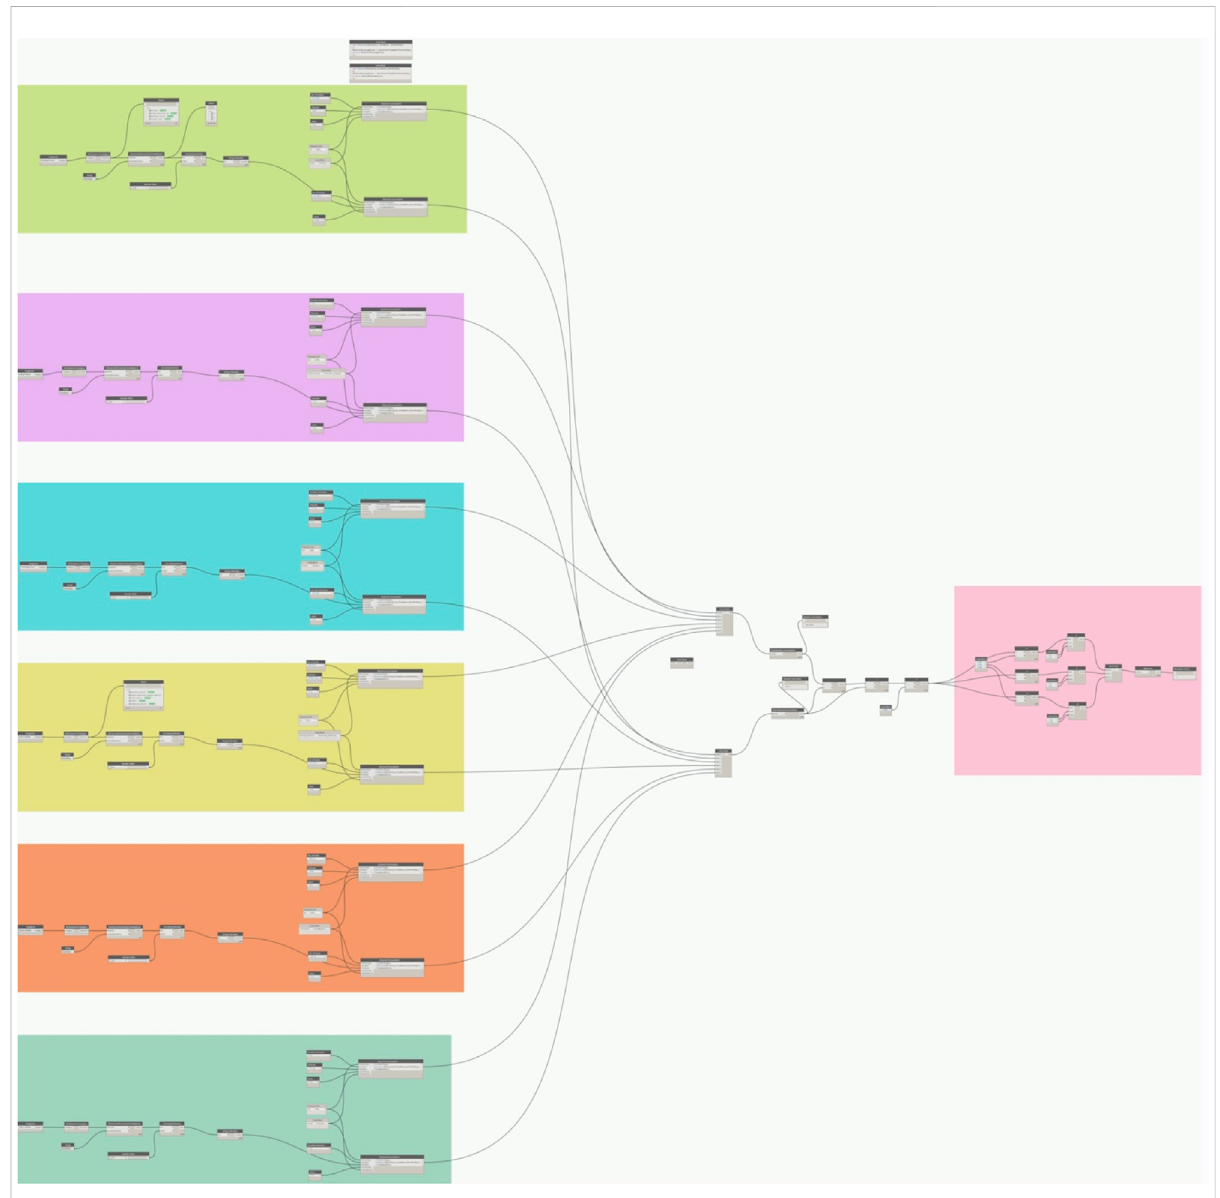
FIGURE 7 Overview of the base